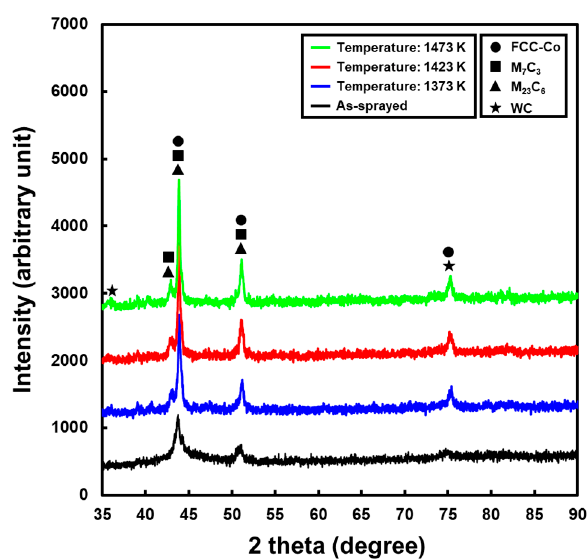
Figure 8. XRD patterns obtained for the as-sprayed Stellite-1 coating and laser heat-treated coating.